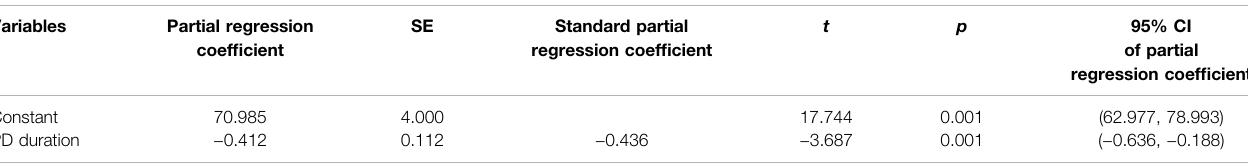
TABLE 3 | Stepwise multiple linear regression analysis of ELA.